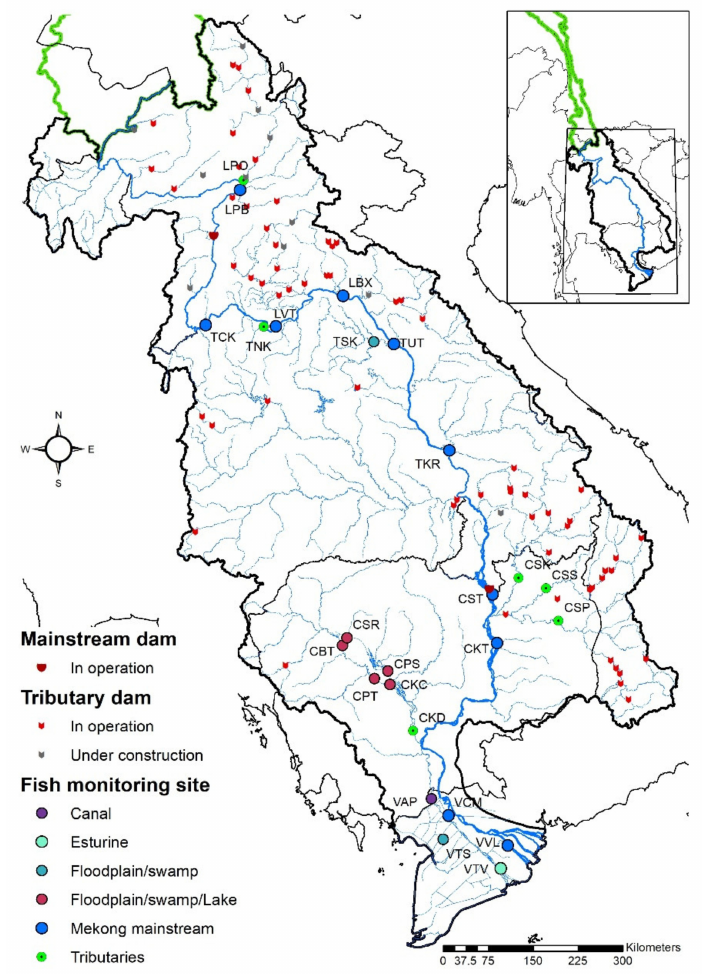
Figure 1. Distribution of monitoring sites and hydropower dams in the Lower Mekong River (Data source: MRC Hydropower Project Database 2019). Site names: LPB = Luangphrabang; LPO = Pak Ou; LVT = Vientiane; LBX = Borikhamxay; TCK = Loei; TNK = Nong Khai; TSK = Sisongkhram; TUT = Tha Uthen; TKR = Ubon Ratchathani; CST = Stung Treng; CSK = Sekong; CSS = Sesan; CSP = Srepok; CKT = Kratie; CSR = Siem Reap; CBT = Battambang; CPT = Kompong Thom; CPS = Pursat; CKC = Kompong Chhang; CKD = Kandal; VAP = An Phu; VCM = Cho Moi; VTS = Thoai Son; VVL = Vinh Long; VTV = Tra